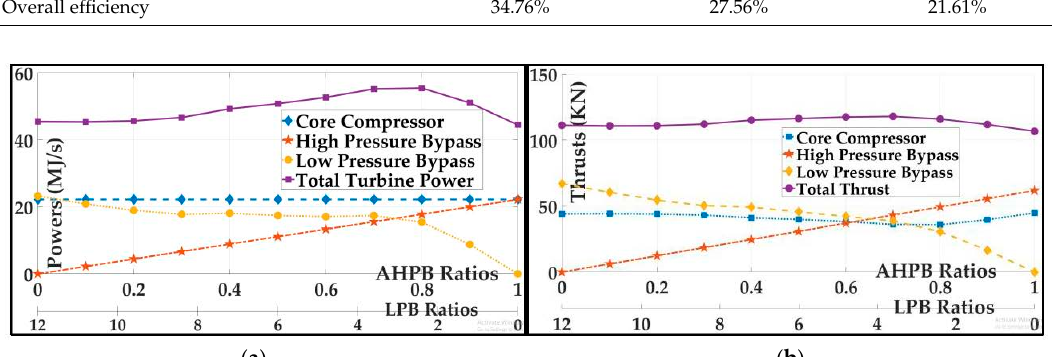
Figure 2. Plots of ( a ) turbine power, and ( b ) thrust as a function of bypass ratios.